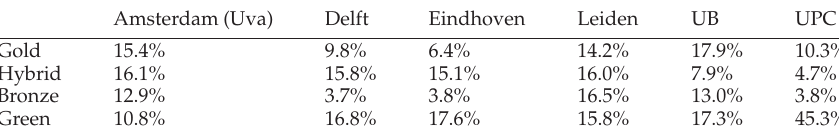
Table 5: Percentages of open access for articles published in 2016 from UB and UPC in comparison to four Dutch universities.